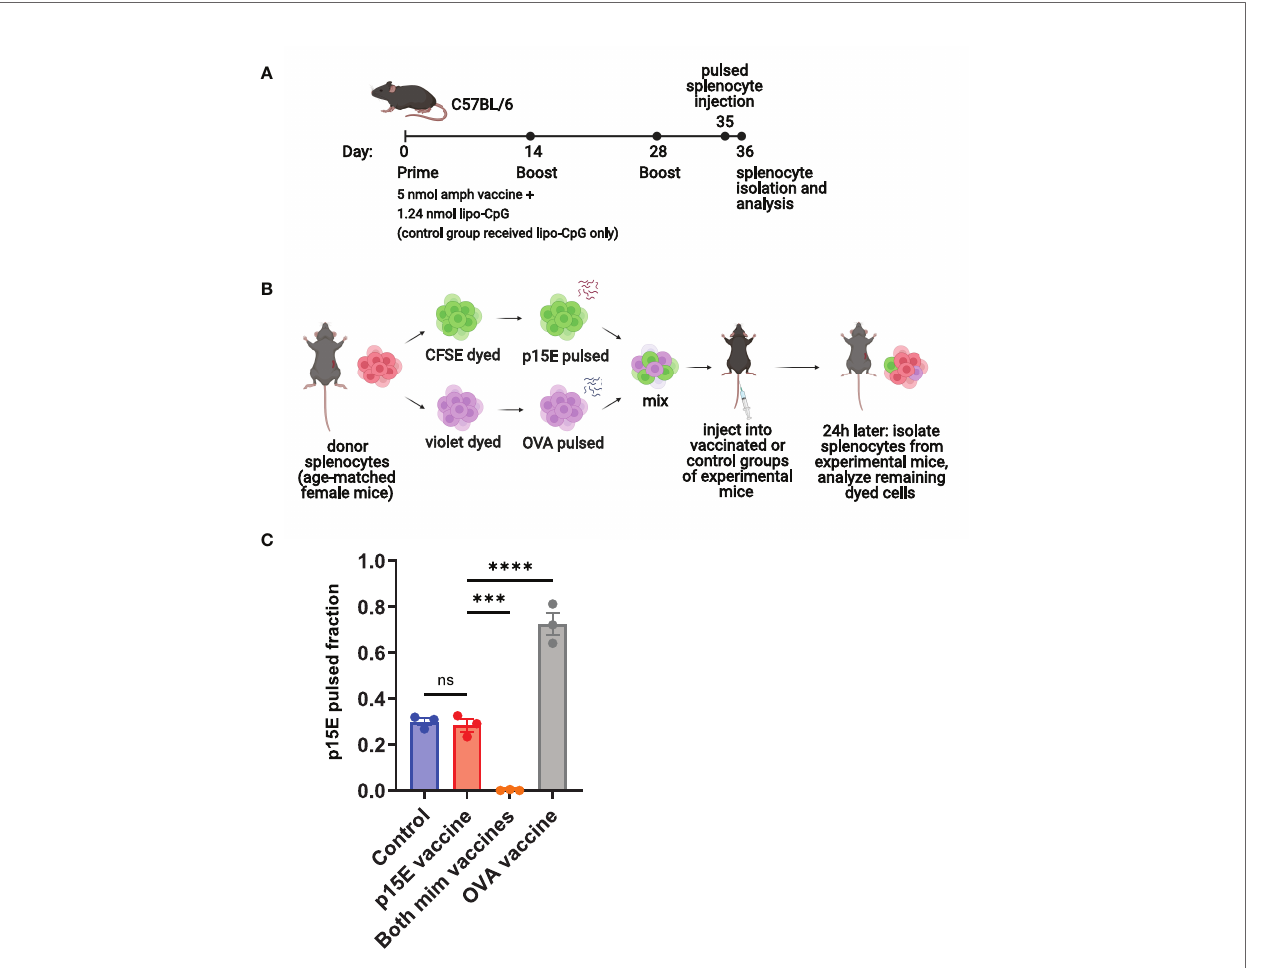
FIGURE 6 | Peptide-pulsed target cells are speci fi cally killed in vivo following vaccination with mimotopes. (A) Timeline of vaccination, donor splenocyte injection, and analysis for vaccinated and control groups of experimental mice. (B) Schematic of day 35-36 protocol for in vivo killing assay. A separate group of age-matched female C57BL/6 mice were used to obtain donor splenocytes, which were pulsed, dyed, and injected into vaccinated or control groups of experimental mice from (A) . (C) On day 36, spleens were removed from experimental mice. Single cell suspensions were generated and analyzed by fl ow cytometry for the presence of CFSE- and violet-dyed cells. ns=not signi fi cant: P > 0.05, ***P < 0.001, ****P < 0.0001 by one-way ANOVA with Tukey ’ s multiple comparisons test. Data shown are mean+s.e.m and are representative of 2 independent experiments. N=3